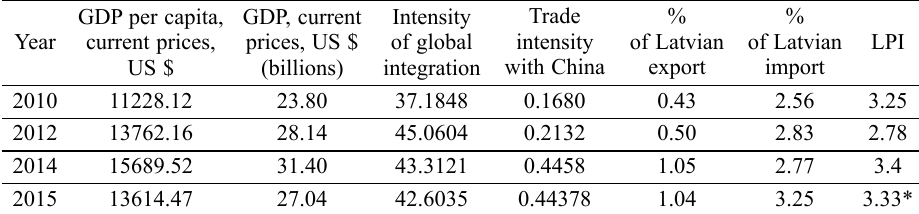
Table 3. Evaluation of the potential of Latvia as a participant of the NSR